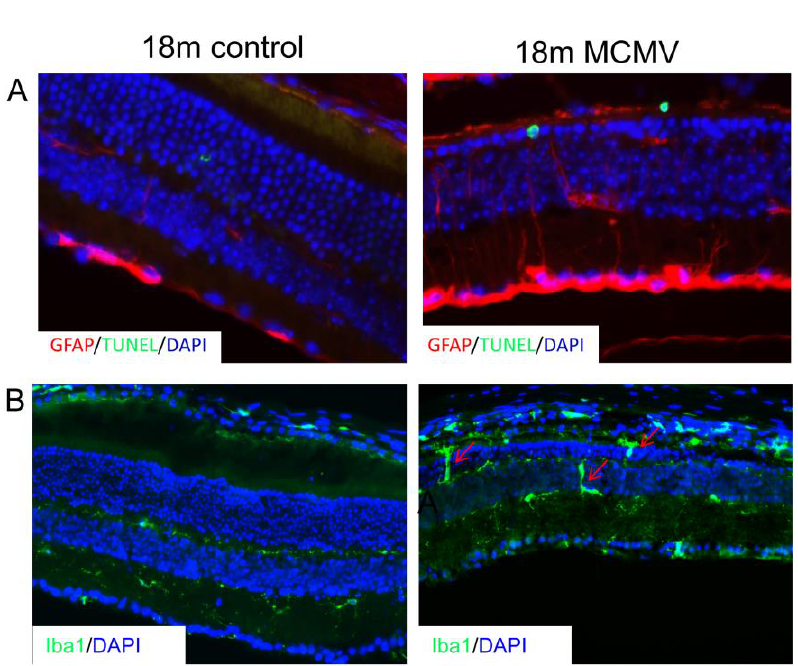
Figure 4. ( A ) Representative merged photomicrographs of stainings for (A) GFAP (red), TUNEL (green), and DAPI (blue) or ( B ) Iba-1 (red) and DAPI (blue) in eyes of latently infected mice at 18 months p.i. (MCMV) together with age-matched control eyes (control).